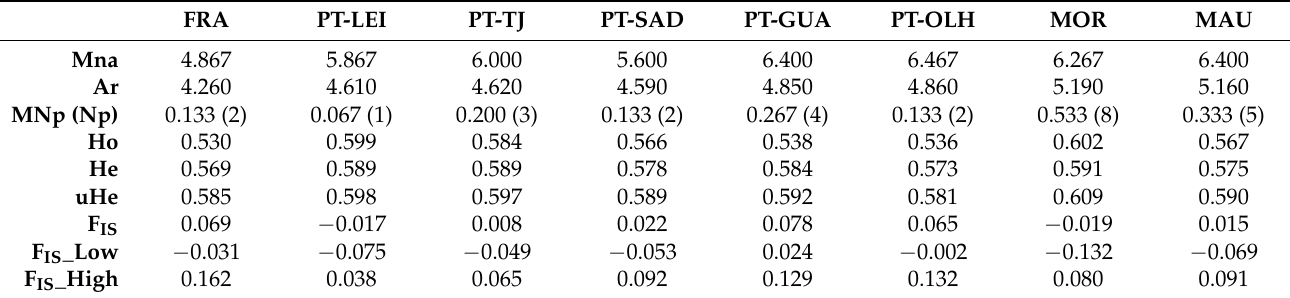
Table 2. Argyrosomus regius genetic diversity estimated using 15 microsatellite loci for Atlantic location sites: mean number of alleles (Mna); mean allelic richness (Ar), mean number of private alleles (MNp), observed heterozygosity (Ho), expected heterozygosity (He), mean unbiased estimate of expected heterozygosity (uHe), and inbreeding coefficient (F IS ), with lower and upper 95% confidence intervals (F IS _Low and F IS _High) determined with 1000 bootstrap replicates). For location sites’